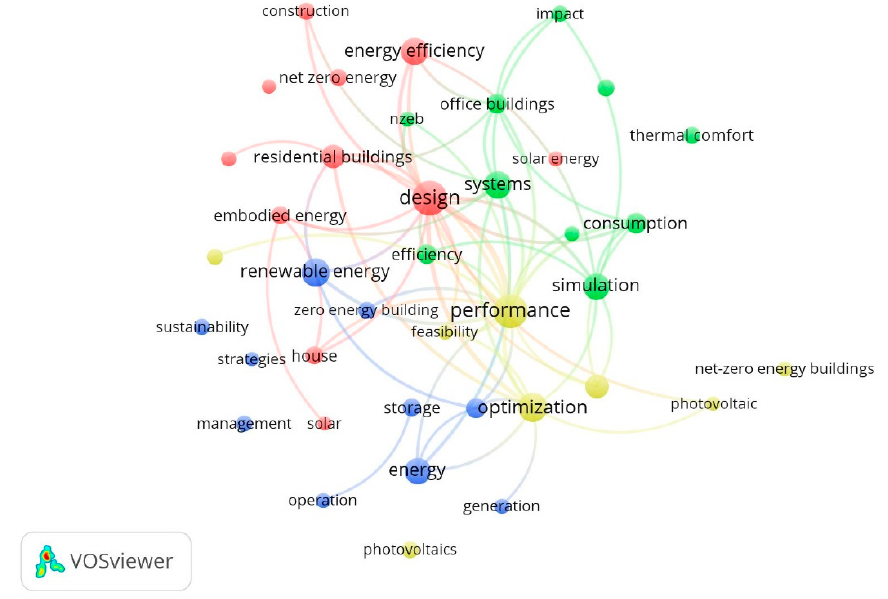
Figure 4. Keywords co-occurrence map representing the relationship between different research topics on NZE.